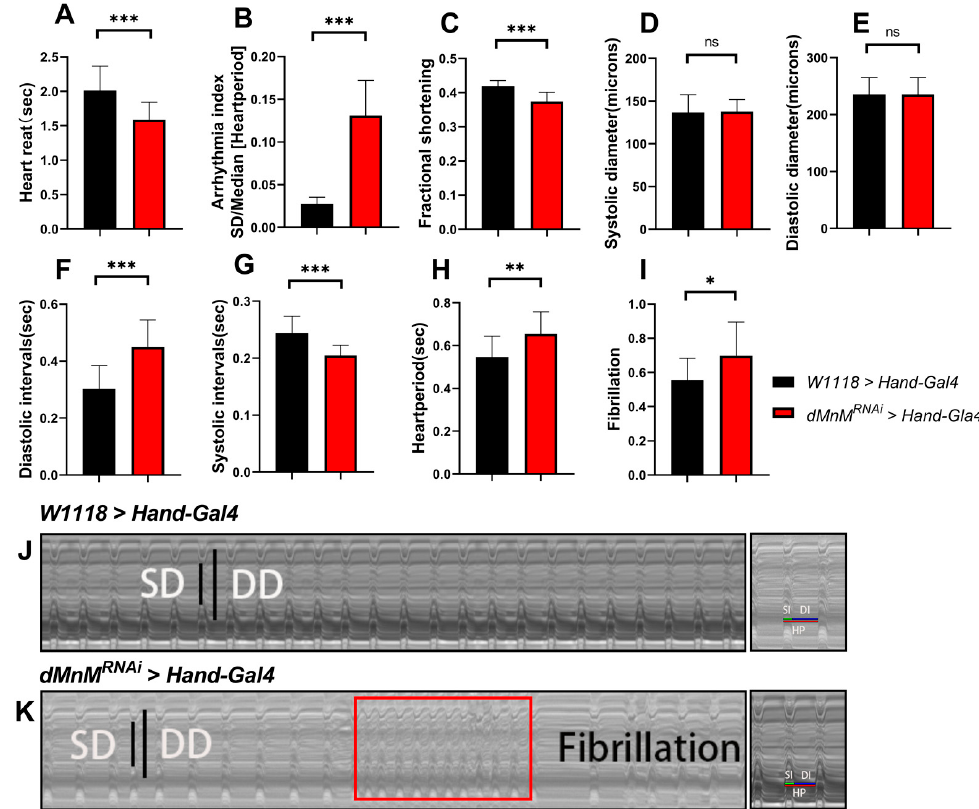
Figure 1. Effects of dMnM knockdown in cardiomyocytes on cardiac function. ( A – H ) M HR, AI, FS, SD, DD, DI, SI, HP, and FL in the W1118 > Hand-Gal4 group and the dMnM RNAi > Hand-Gal4 group; all Drosophila females, n = 30. ( I ) Drosophila fibrillation level in Drosophila . ( J , K ) ECG pattern. Long and short black lines represent diastolic diameter and systolic diameter, respectively. The red square shows fibrillation. All M-mode ECGs were intercepted at 10 s. An independent-samples t -test was used to evaluate the differences between the two groups, * p < 0.05, ** p < 0.01, *** p < 0.001, ns is not statistically significant.